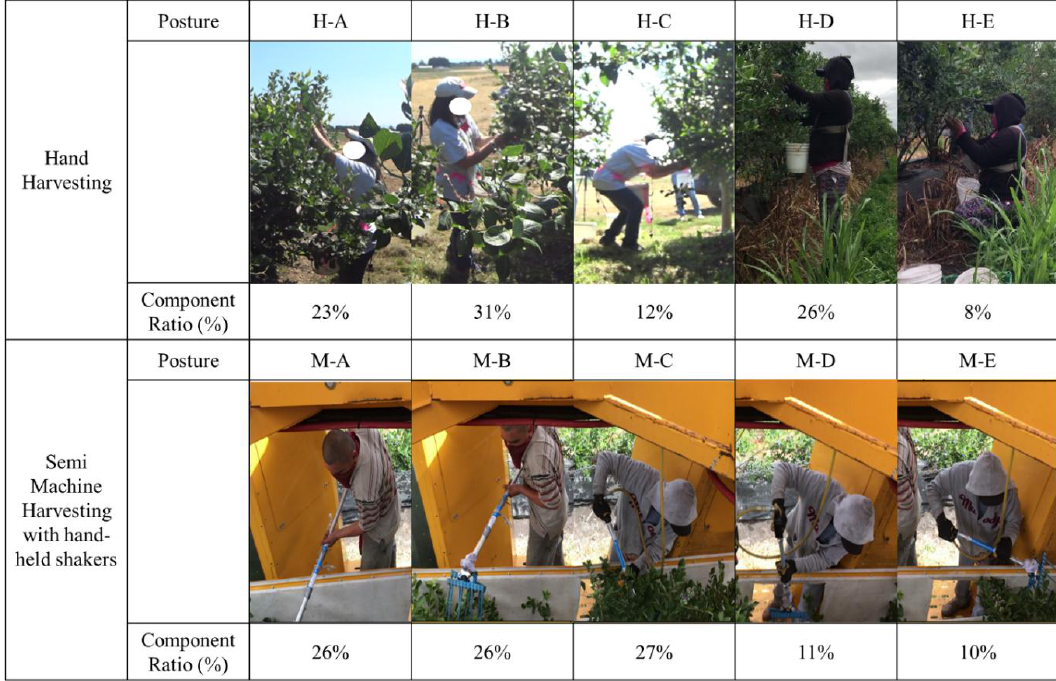
Figure 4. Examples of categorized harvesting postures and component ratios of each posture group: For hand harvesting, high (H-A), middle (H-B), low (H-C), stretch (H-D), and squat (H-E); for semi-machine harvesting, push in high position (M-A), pull in high position (M-B), push in low position (M-C), pull in high position (M-D), and standing (M-E).